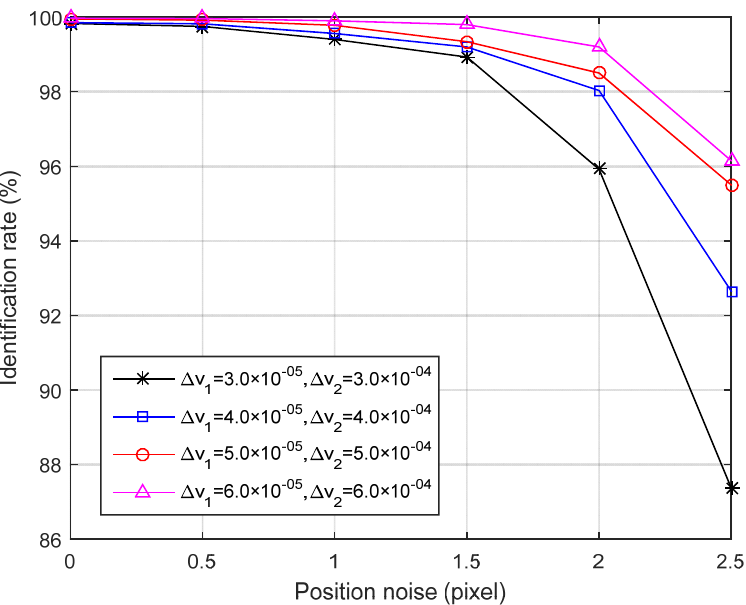
Figure 5. Identification rate versus positional noise with the different discretized